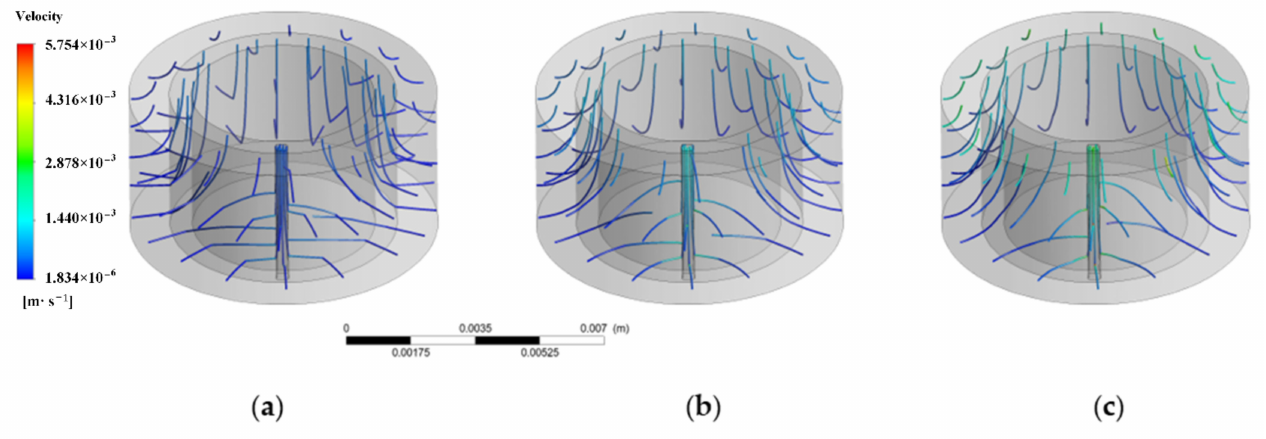
Figure 19. The velocity streamlines for cases with different rock permeability. ( a – c ): k1 (krock < kinterface), k2 (krock = kinterface), k3 (krock >